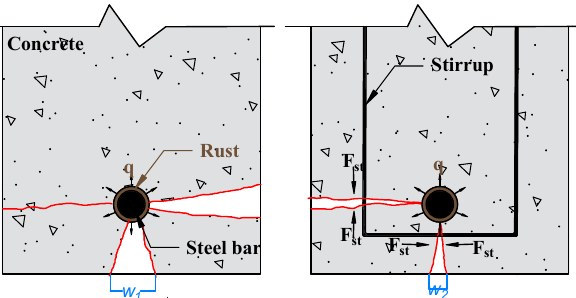
Figure 16. Effect of stirrups on corrosion-induced cover cracking. Reprinted with permission from [47]. 2016, Elsevier.